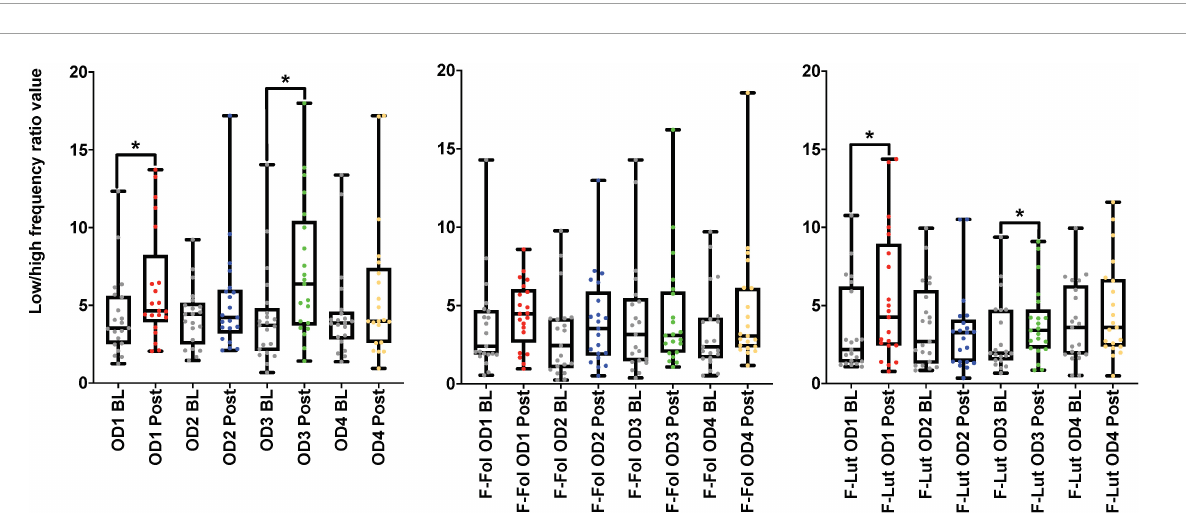
FIGURE4 Results from the baseline (BL) and post-stimulation (Post) periods comparisons, with a focus on the low-high frequency ratio (LF/HF ratio), the electrocardiogram (ECG) frequency-domain parameter from both cohorts. The figure on the left represents the LF/HF ratio results from the male cohort, while the ‘F-Fol’ represents the female cohort in the follicular-menstrual stage, while ‘F-Lut’ represents the female cohort in the luteal-menstrual stage. Each graph in the compilation represents each odor (OD1—mushroom, OD2—lavender, OD3—jasmine, OD4—rose). * – p -value <